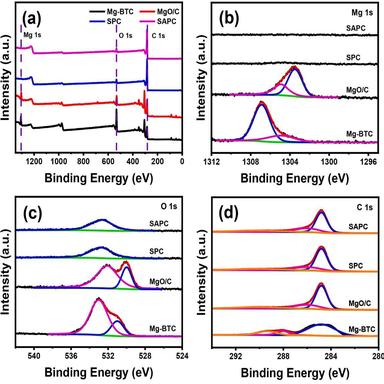
XPS spectra, (a) the full survey, (b) Mg 1 s, (c) O 1 s and (d) C 1 s of Mg-BTC, MgO/C, SPC and SAPC.